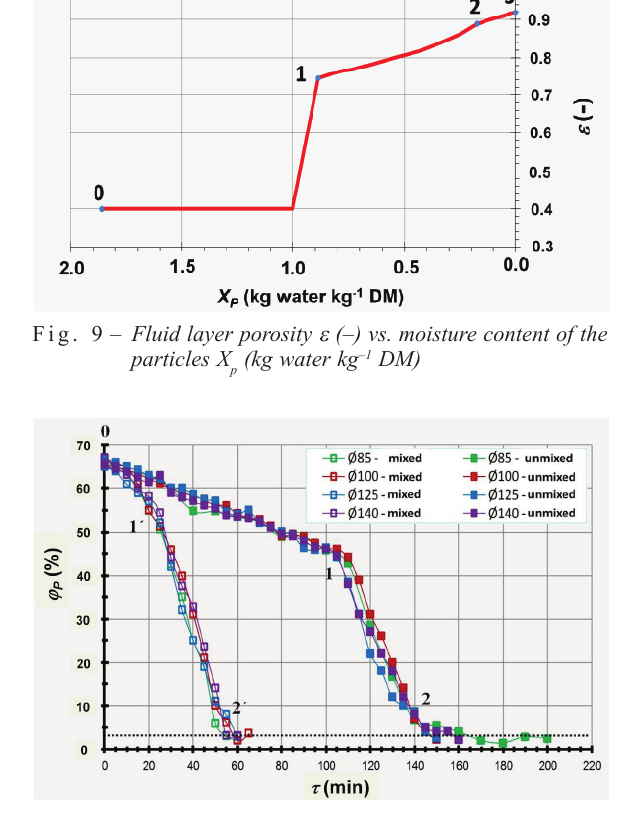
Fig. 10 – Resulting drying curves for mixed and unmixed fluid beds (fluidized-bed dryer chamber diameters 85 mm; 100 mm; 125 mm, and 140 mm; drying air temperature 120°C) Dotted line = prescribed final moisture of the particles Pavel Hoffman: Effect of fluidized bed stirring on drying process of adhesive particles